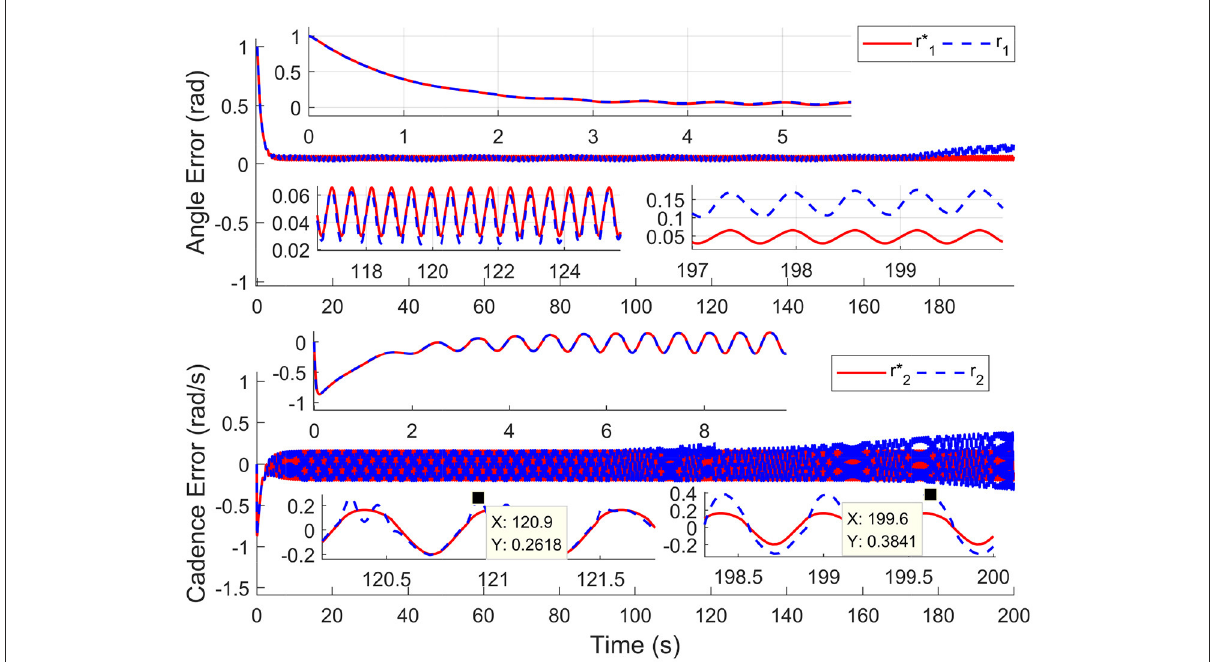
FIGURE3 The tracking errors for nominal system and time delays system. The red solid lines ( r ∗ 1 , r ∗ 2 ) and the blue dotted lines ( r 1 , r 2 ) represent the tracking errors of the nominal and time delay systems,